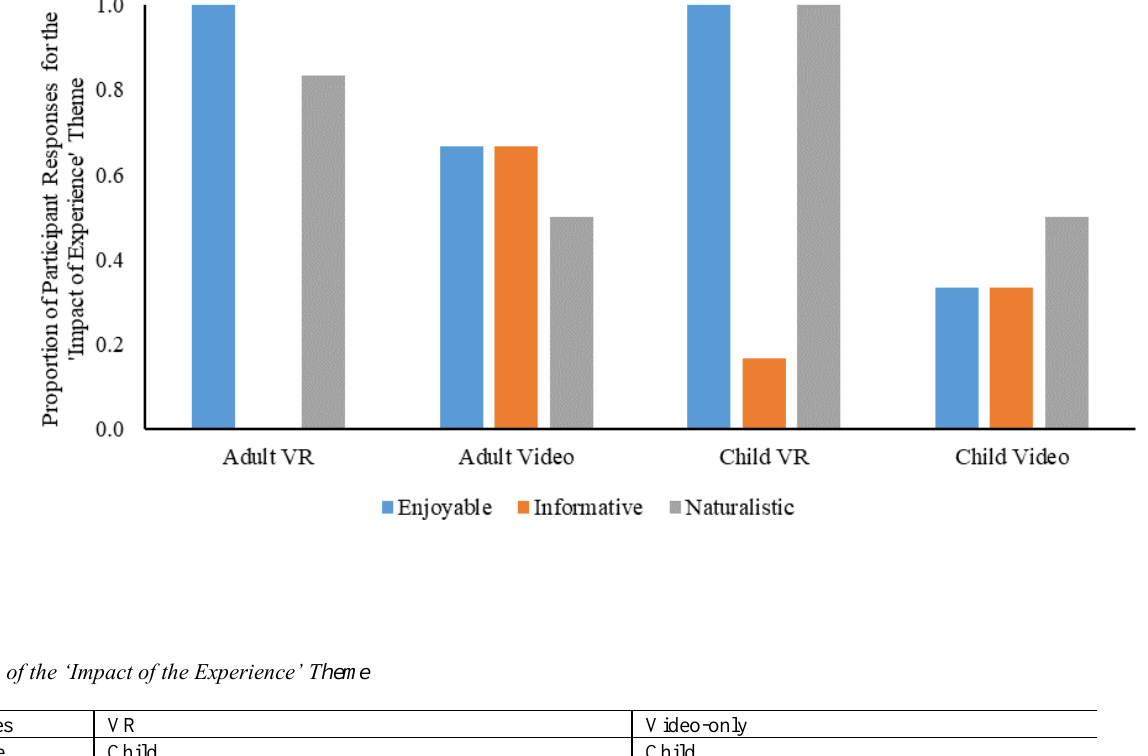
Summary of ‘Impact of Experience’ Theme by